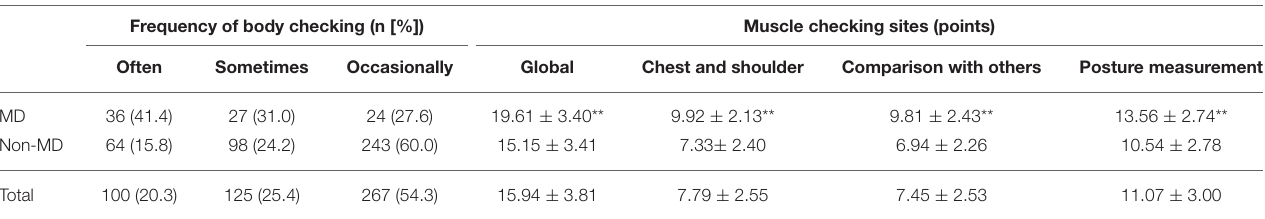
TABLE 3 | Contingency table on body checking and the descriptive statistics of physique anxiety scores between and without muscle dysmorphia. Frequency of body checking (n [%]) Muscle checking sites (points) Often Sometimes Occasionally Global Chest and shoulder Comparison with others Posture measurement